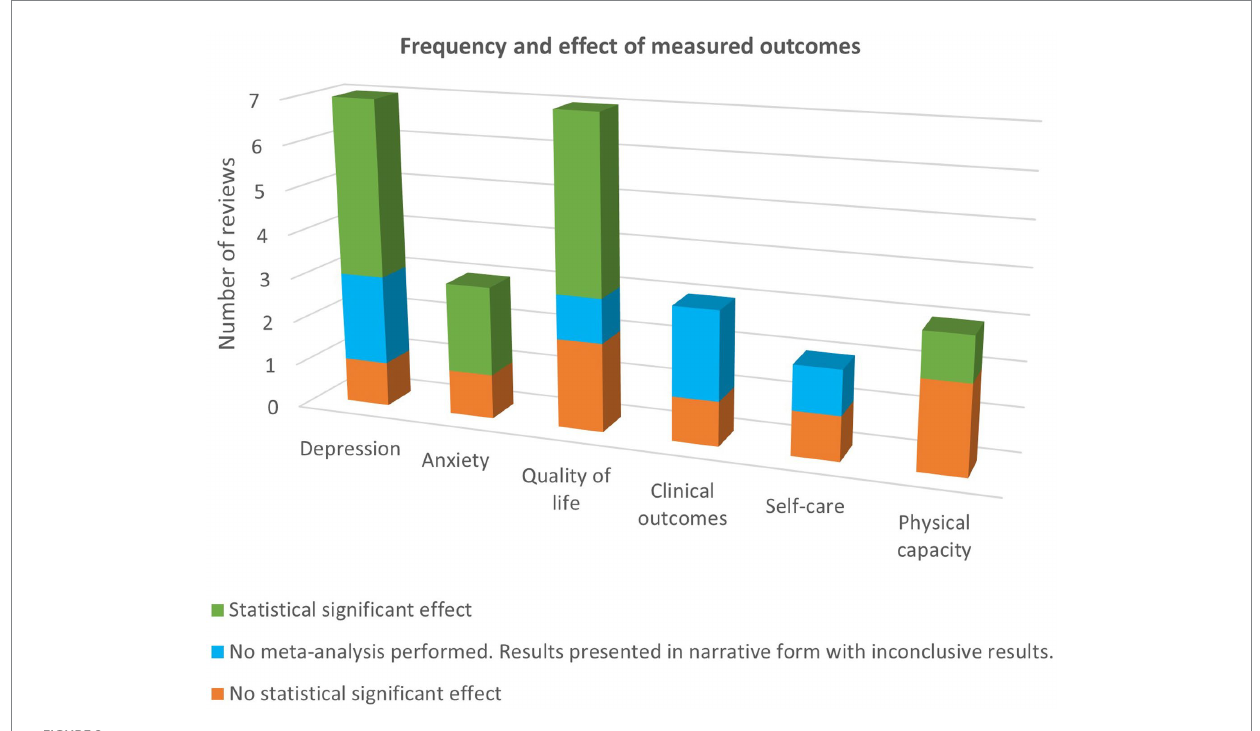
FIGURE 2 Frequency and effect of measured outcomes at the first post-intervention measurement